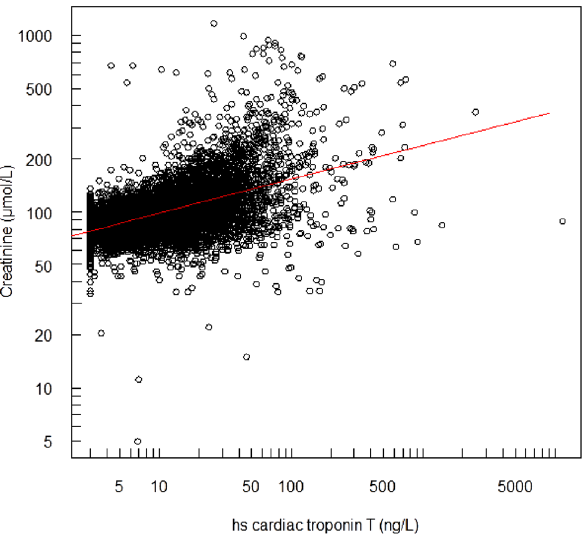
Figure 2: Creatinine concentrations and high sensitive cardiac troponinT(hscardiactroponin)concentrationspresentedonlnscales. The data were from male ambulant patients of a university hospital. Analysis for both hs-cTnT and creatinine were performed on the same sample. The red line is the regression function.